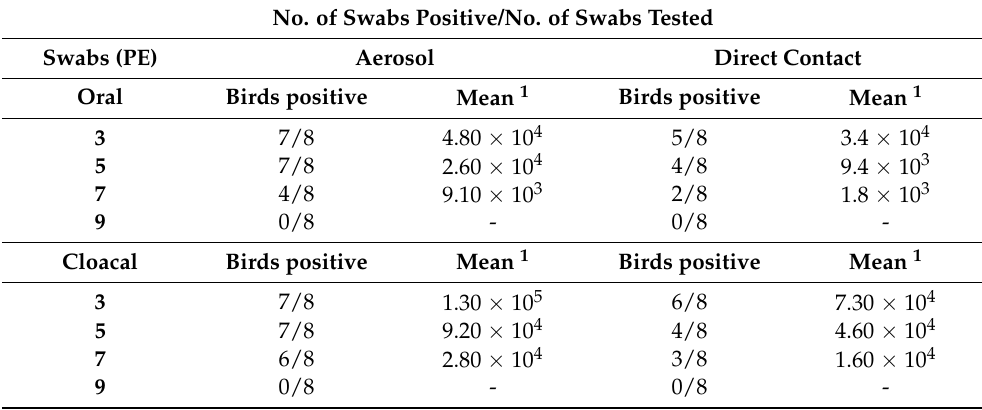
Table 2. Rate of infection in recipient chickens of aerosol and direct inoculation groups. No. of Swabs Positive/No. of Swabs Tested Swabs